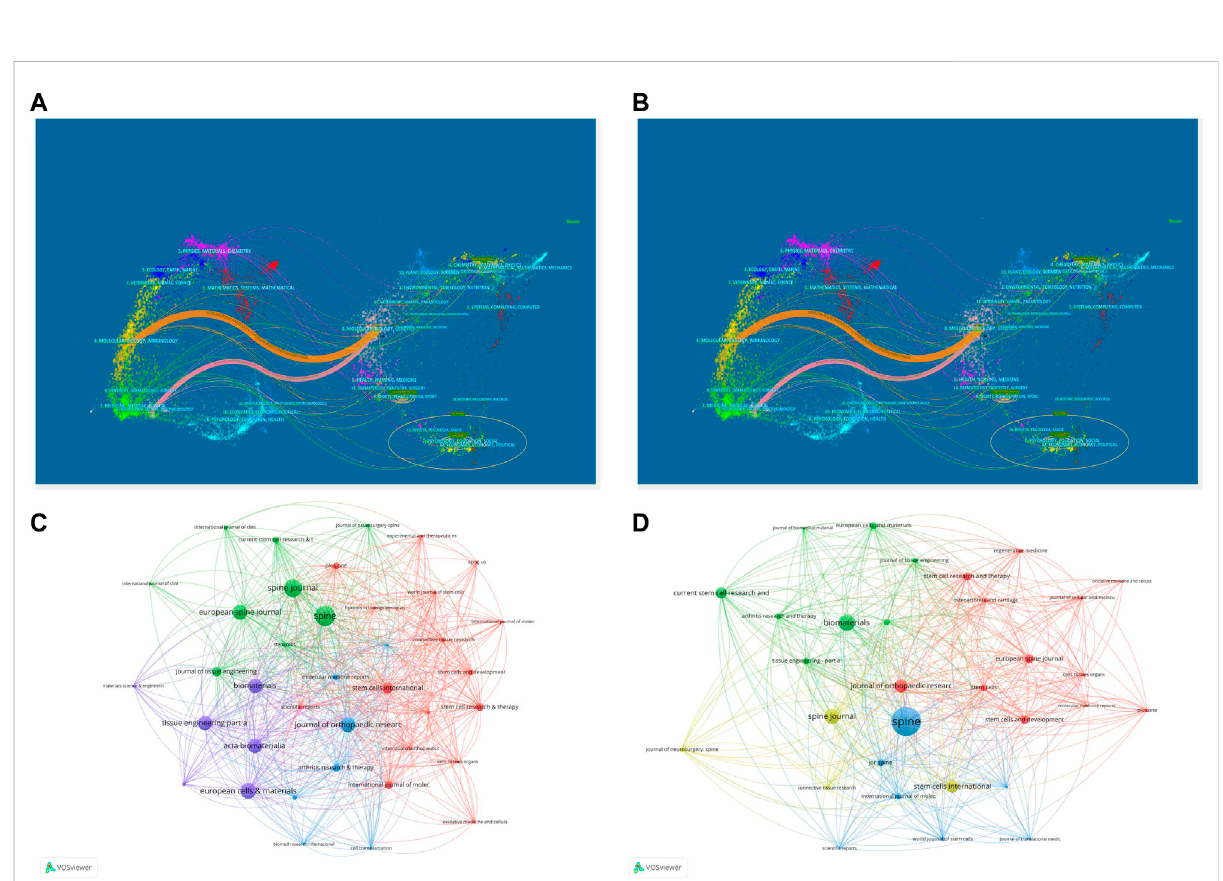
FIGURE 6 Thedual-mapoverlayofjournalsinWOSCC (A) andScopus (B) .Thedual-mapoverlayofthejournalshowedatotalofonepinkprimarycitation path and one orange primary citation path. The journal network graph in WOSCC (C) and Scopus (D) . In WOSCC, key journals formed 4 clusters and 4 clusters were formed from